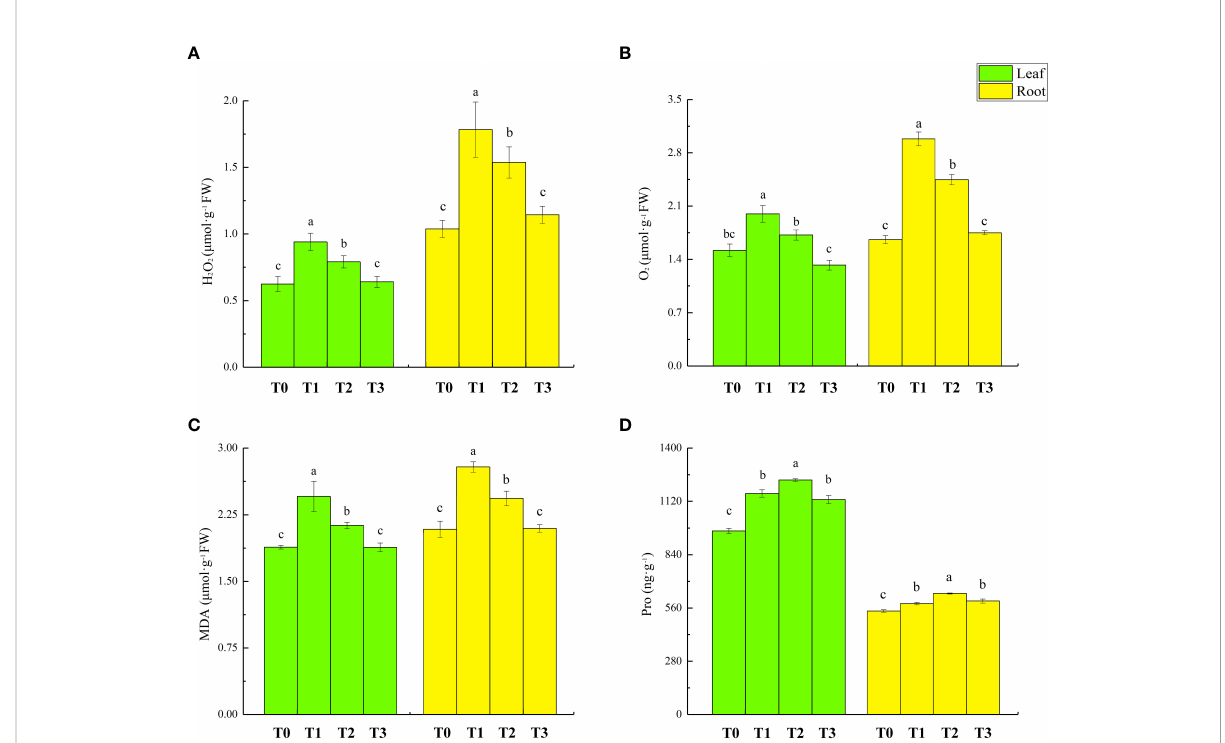
FIGURE 3 Effect of ZnONPs on hydrogen peroxide (H 2 O 2 ) content (A) , superoxide radicals (O 2- ) content (B) , malondialdehyde (MDA) content (C) and proline (Pro) content (D) , in leaves and roots of lettuce. T0, no treatment; T1, exposure to 1 mg/l Cd; T2, exposure to 1 mg/l Cd and 2.5 mg/l ZnONPs; T3, exposure to 2.5 mg/l ZnONPs. Data are shown as means ± SE of three replicates. Bars marked by different letters indicate signi fi cant differences according to Duncan ’ s test ( p